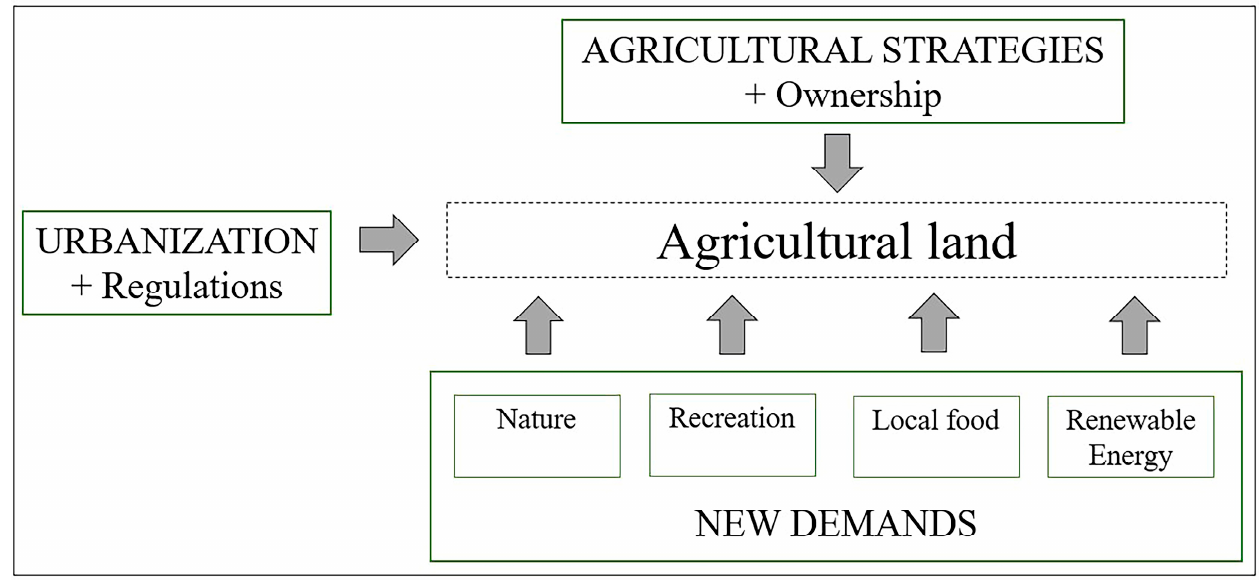
Figure 3. The three main driving forces influencing agricultural estates at the edge of Walloon cities.